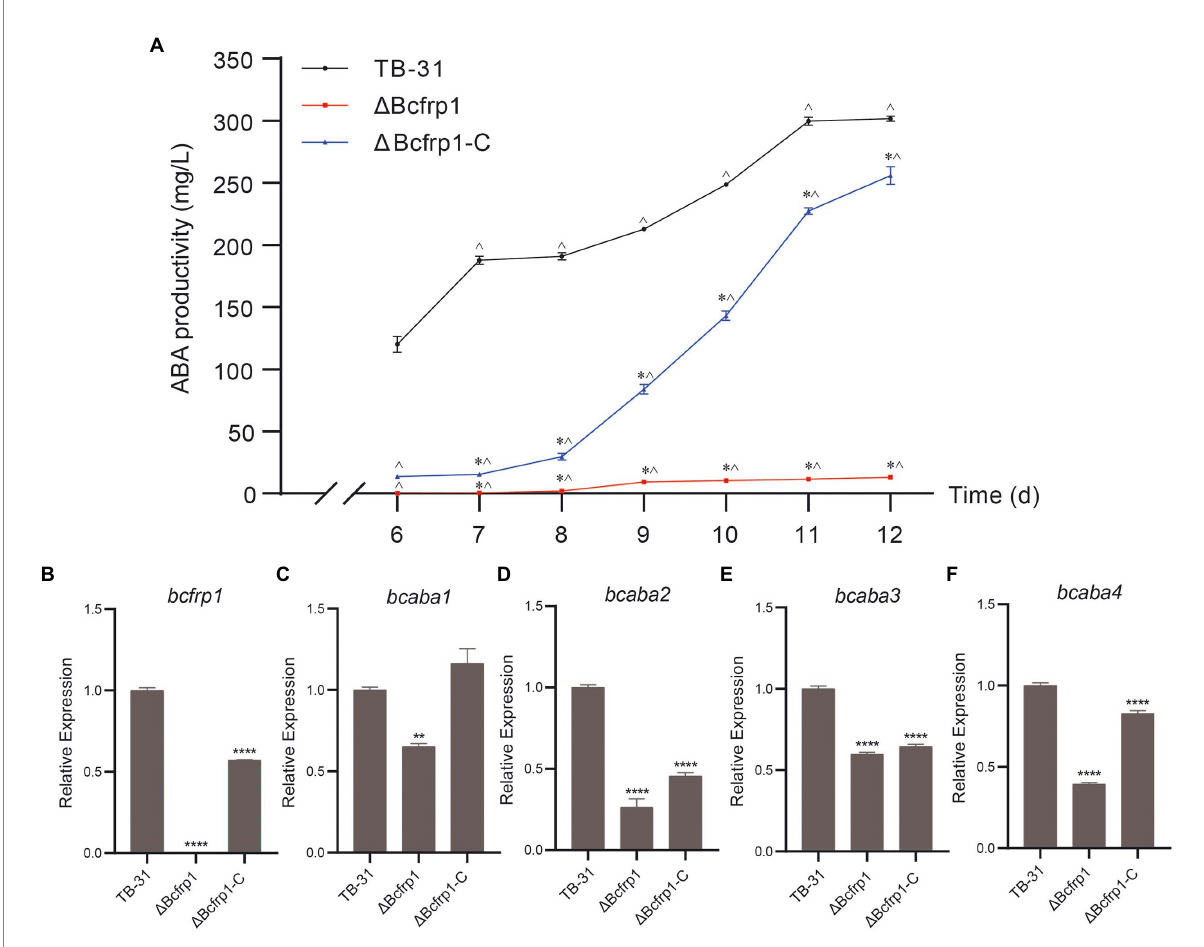
FIGURE 1 Bcfrp1 is required for ABA yield in Botrytis cinerea TB-31. (A) ABA production of B. cinerea TB-31, Δ Bcfrp1 and Δ Bcfrp1-C mutant strains which were cultured on PDA plates at 26 ° C. Samples to test for ABA production were collected at seven time points (6, 7, 8, 9, 10, 11 and 12 days). The error bars indicate the standard errors of the means ± SEM; n = 3 replicate cultures. *, p < 0.05 versus the 6-day group; ^, p < 0.05 versus the TB-31 groups at the same time. (B–F) qRT-PCR examining the transcription levels of bcfrp1 , bcaba1 - 4 in mutant Δ Bcfrp1, Δ Bcfrp1-C and the parental strain, TB-31. Relative transcription levels of bcfrp1 , bcaba1 - 4 were generated after normalization to the constitutive tubulin reference gene tubA for 6 days. The relative values for bcfrp1 , bcaba1 - 4 transcription for 6 days in TB-31 were arbitrarily assigned a value of 1. Shown are means ± SEM; n = 3 replicate cultures. **, p < 0.01 versus the transcription level of the TB-31 group; ****, p < 0.001 versus the transcription level of the TB-31